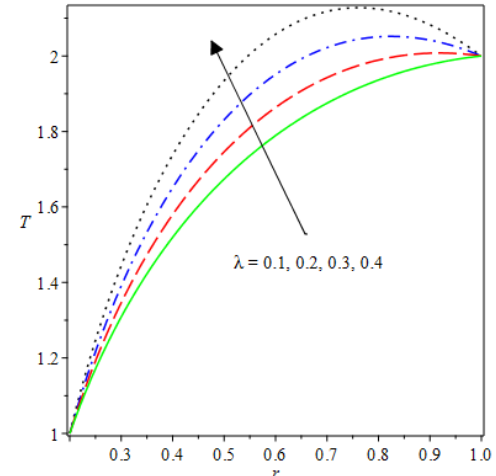
Figure 2. Heat distribution for varying ( γ ) .